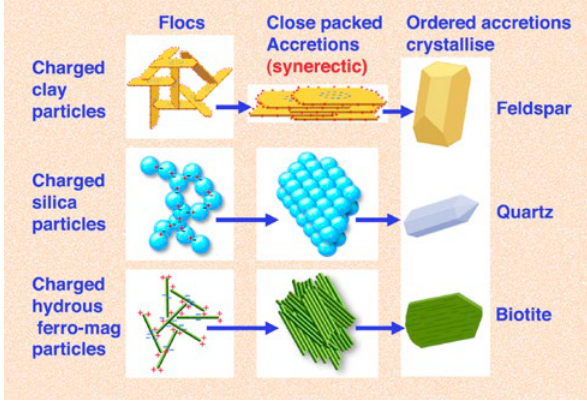
RECOGNITION OF THE PRECURSOR PRINCIPLE